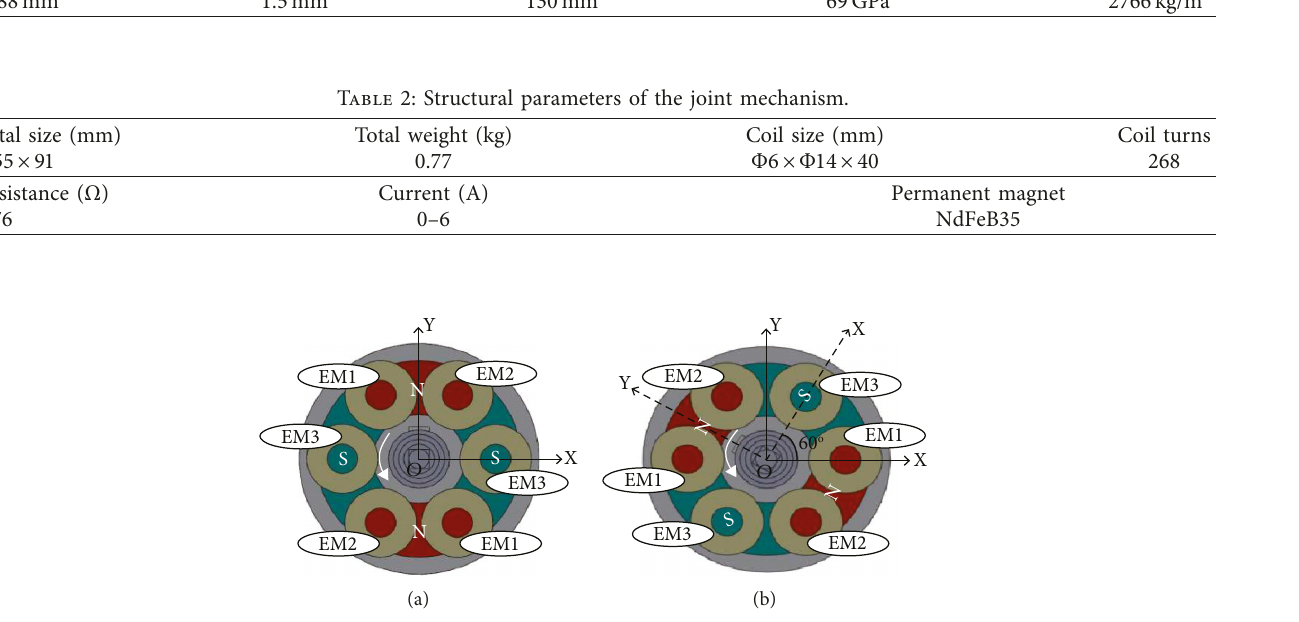
Figure 4: Relative rotation direction of the coil stator and the permanent magnet rotor: (a) initial position of the coil stator and the permanent magnet rotor and (b) the permanent magnet rotor rotating to 60 ° .